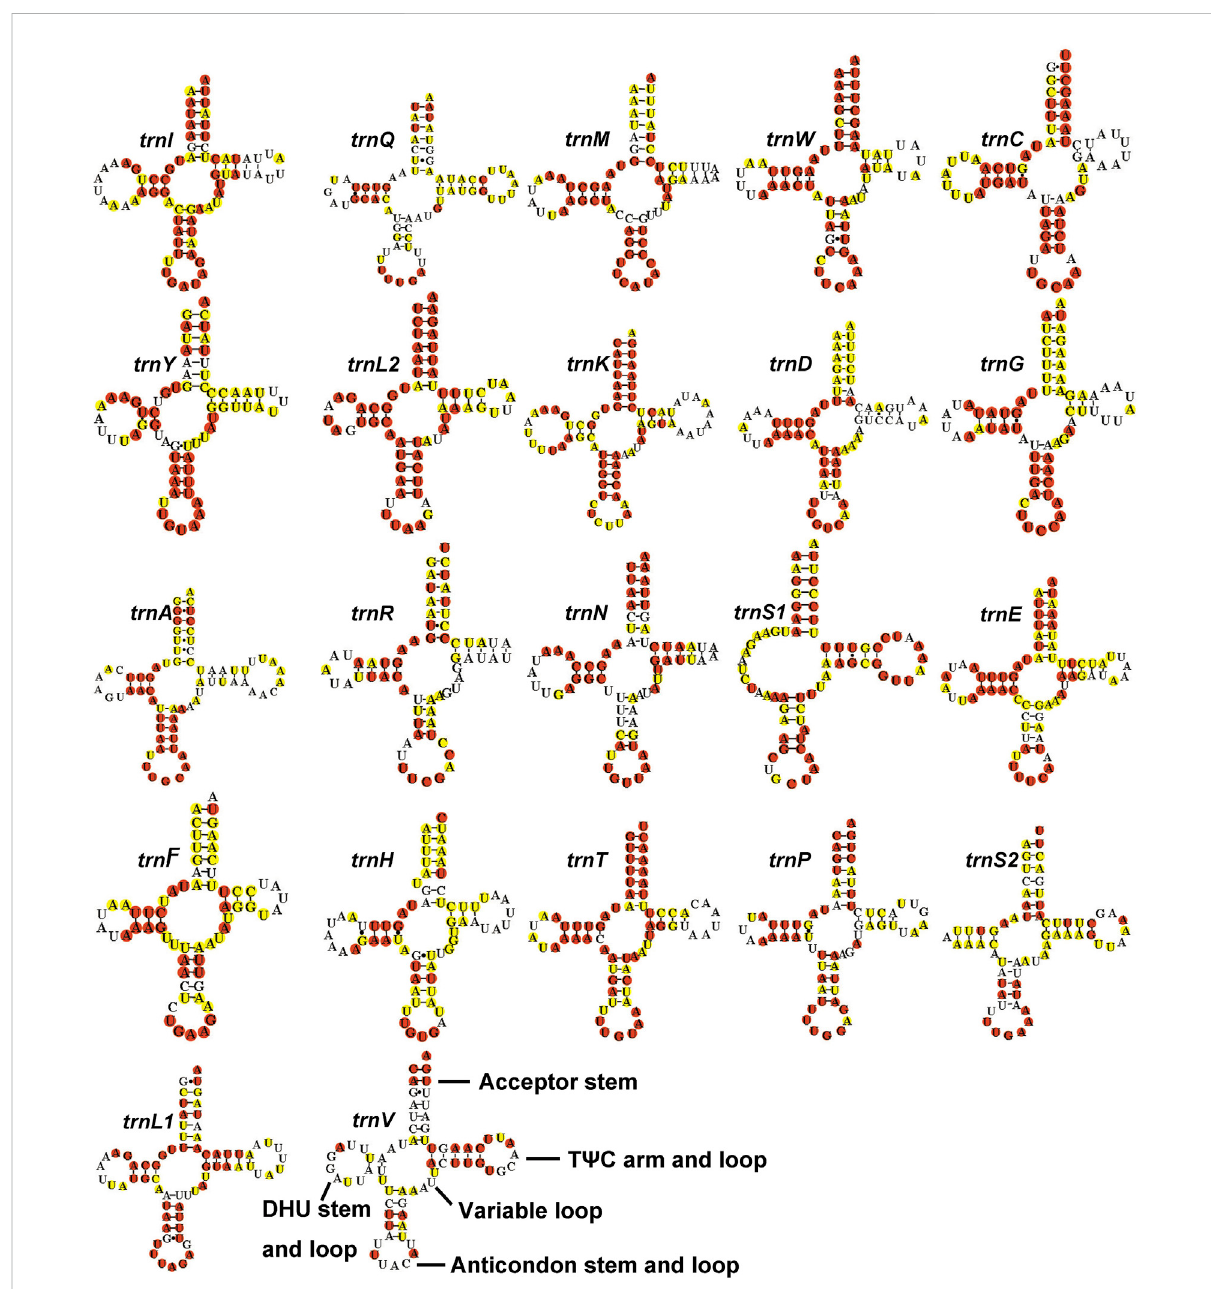
FIGURE 4 The potential secondary structure of the tRNA in Gonopsis coccinea . Conserved sites are marked red in Pentatomidae and yellow in